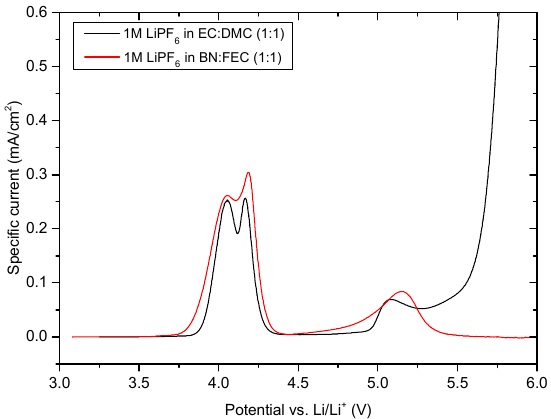
Figure 2. Linear sweep voltammograms of cells containing 1M LiPF 6 in BN:FEC (1:1) and 1M LiPF 6 in